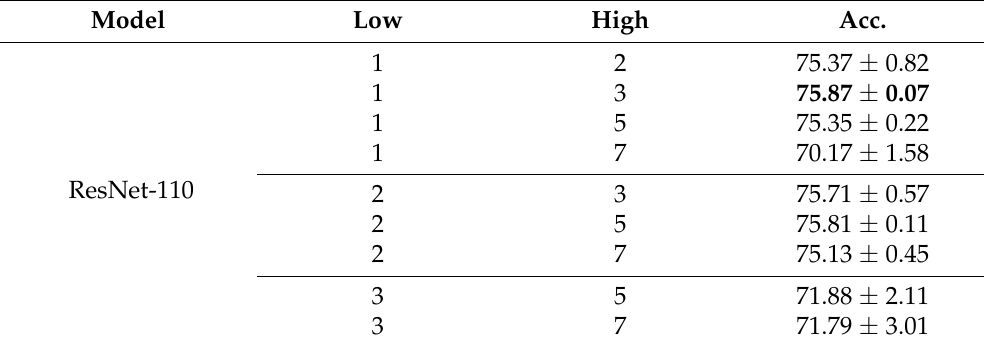
Table 8. Impact on parameters of different low , high with fixed probability of p r = 0.5 when taking RALR